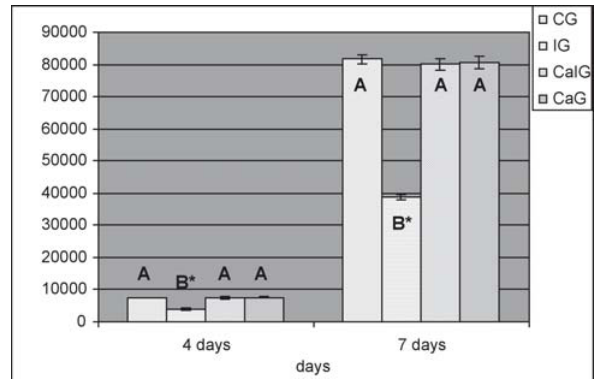
FIGURE 3- Means and standard deviation of the birefringence of collagen fibers (ìm 2 ) on the 4 th and 7 th day of tissue evolution. Letters differ statistically between them, with significant p-value of 5%, by the Tukey